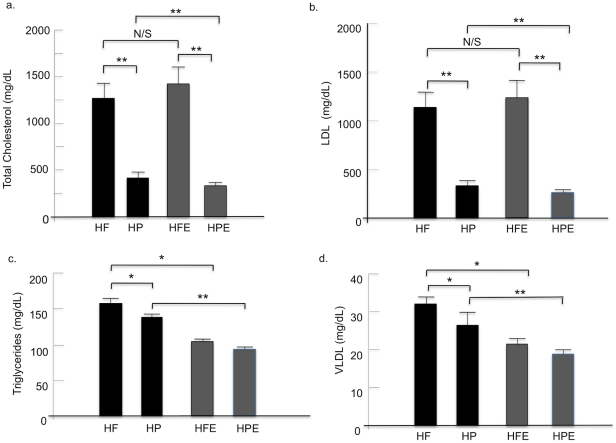
Comparisons of lipid profiles between groups.Blood was collected at the time of sacrifice in all groups. Total cholesterol (TC), HDL, triglycerides (TG), LDL and VLDL were measured by gas chromatography. HF, HP, HFE, HPE as in Figures 1 and 2. Each value represents the mean plasma lipid level for the exercise period ± SEM; two-way ANOVA was used as described for Figure 3; **p<0.001; *p<0.05.